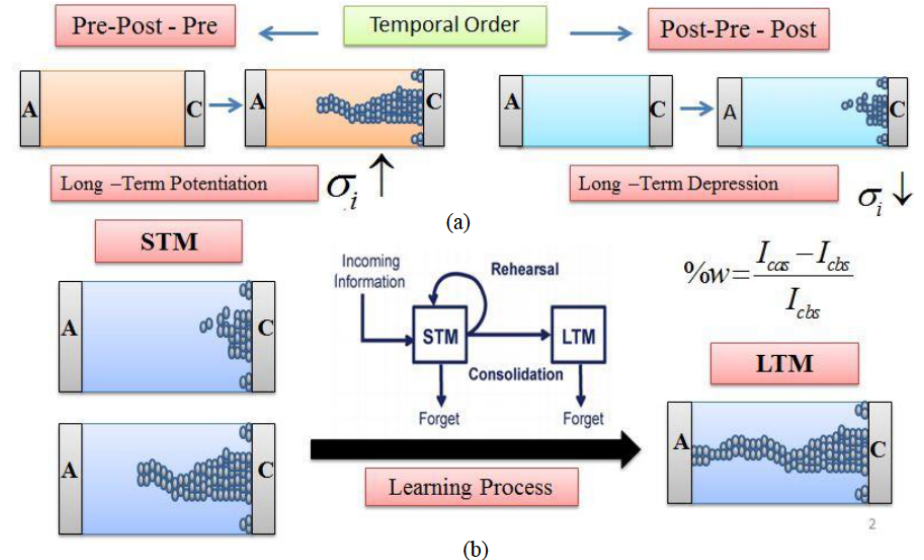
Figure 14: (a) Pictorial representation of the phenomenon of Long- term potentiation and depression on the basis of formation and rupture of filament. The increase in change in weight causes rise in the size of the filament causing long term potentiation while vice versa upon decrease in change in weight (b) Learning process is illustrated where repeated stimulation causes transit from Short- Term memory (STM) to Long-Term Memory (LTM) causing a gradual increment in the size of filament.